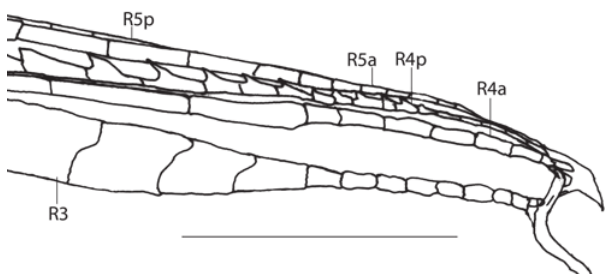
Fig. 3. Gonopodium tip of Phalloceros mikrommatos , UFPB 2214. R3, R4a, R4p, R5a, R5p indicate gonopodial rays. Scale bar 1 mm.